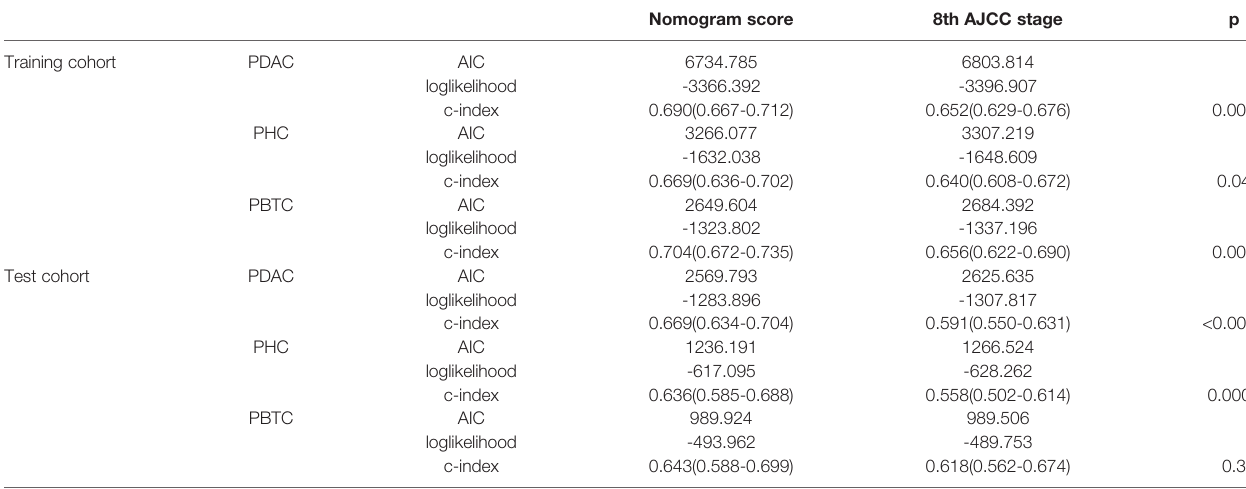
TABLE 5 | Comparison of nomograms with the AJCC staging system.